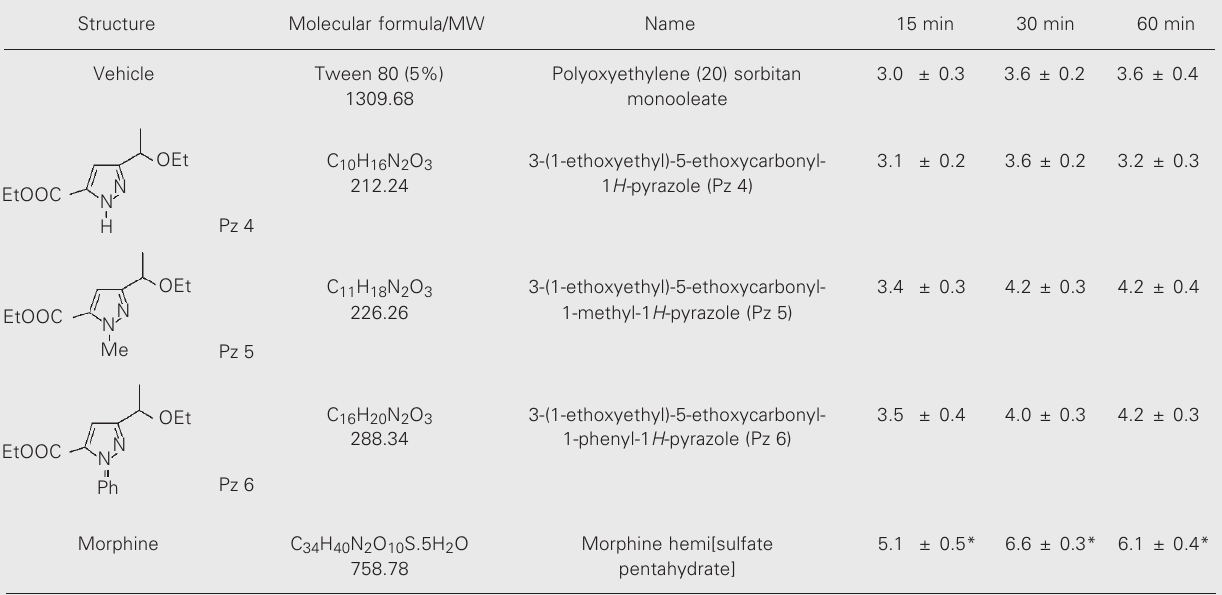
Table 2. Effects of pyrazoles 4, 5 and 6 and morphine on mouse tail withdrawal latency (in seconds) at 15, 30 and 60 min after